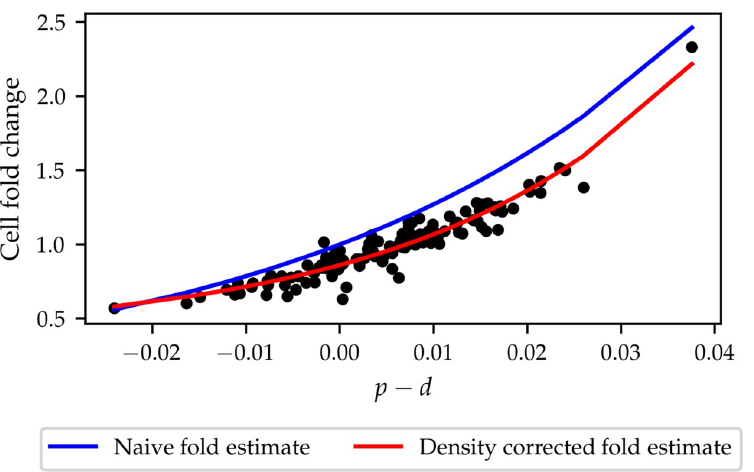
Fig 8. Observed cell fold change as a function of intrinsic net proliferation rate, p − d . When density-dependent effects are ignored (blue) line, the estimate of cell fold change as a function of net intrinsic proliferation overestimates cell fold change. When density-dependent effects are considered, model predictions accurately capture cell fold